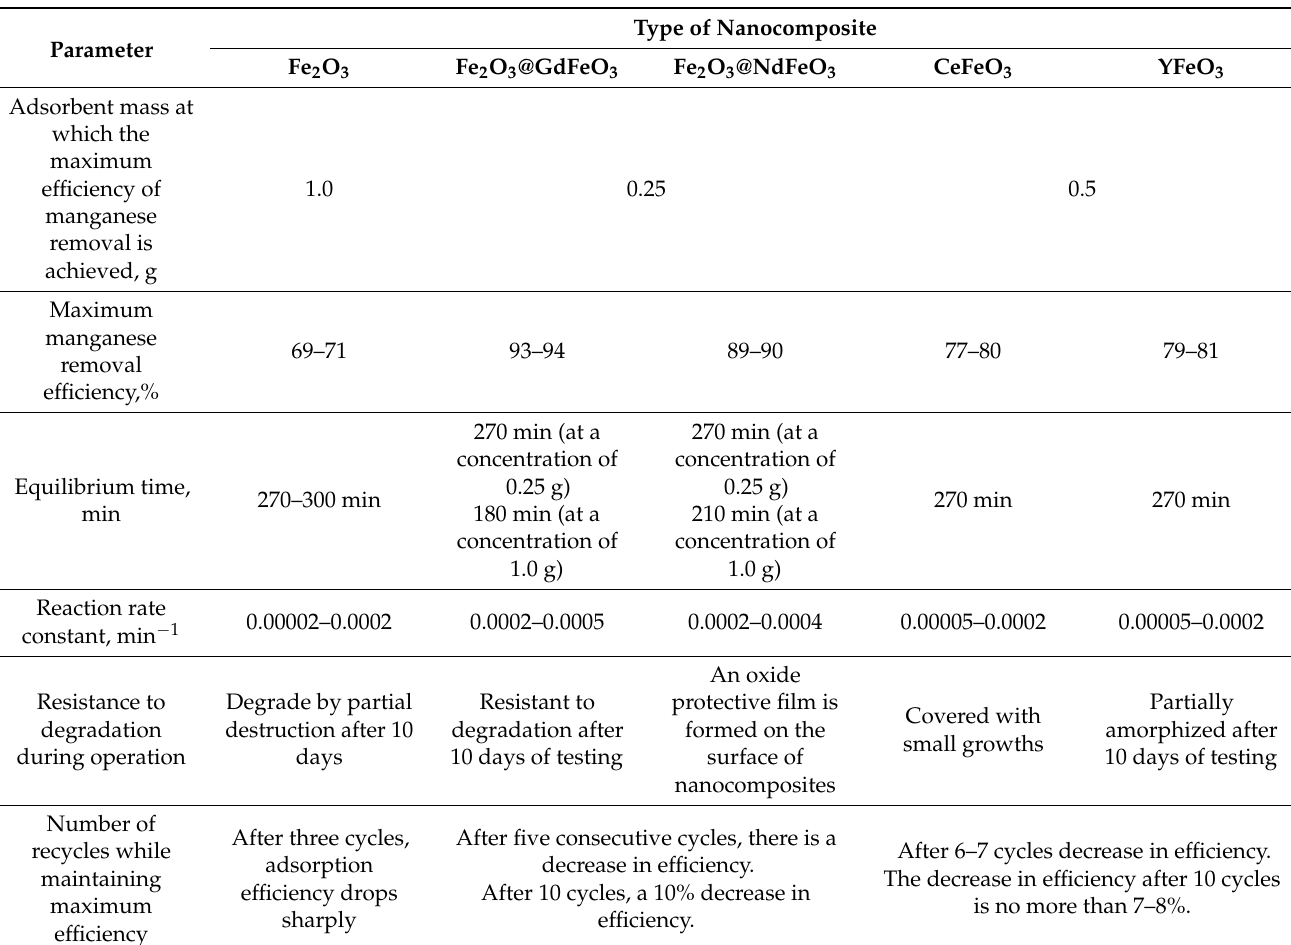
Table 2. Comparative analysis